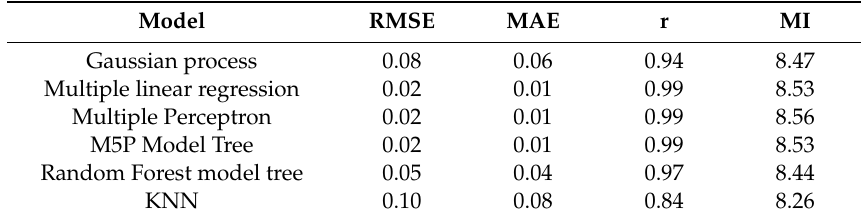
Table 11. Summary of performance of multiple ML models with training data from 2003 to